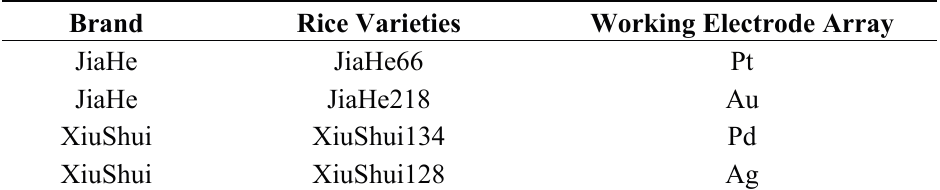
Table 1. Experimental samples with different four